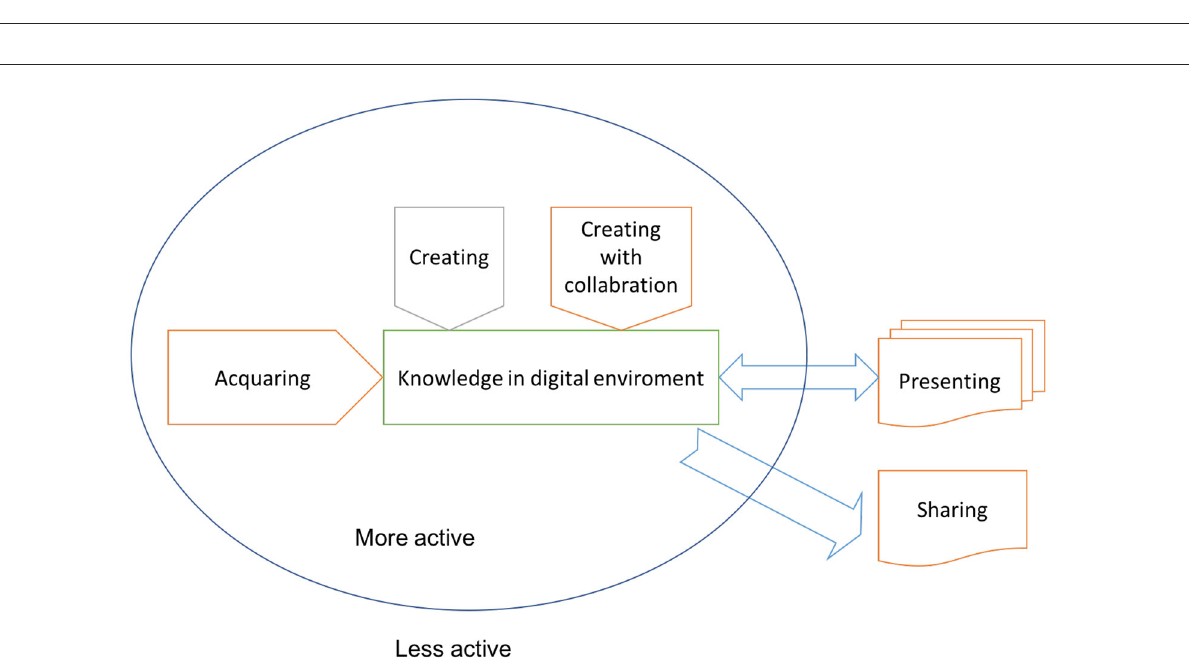
FIGURE3 Framework on knowledge in digital